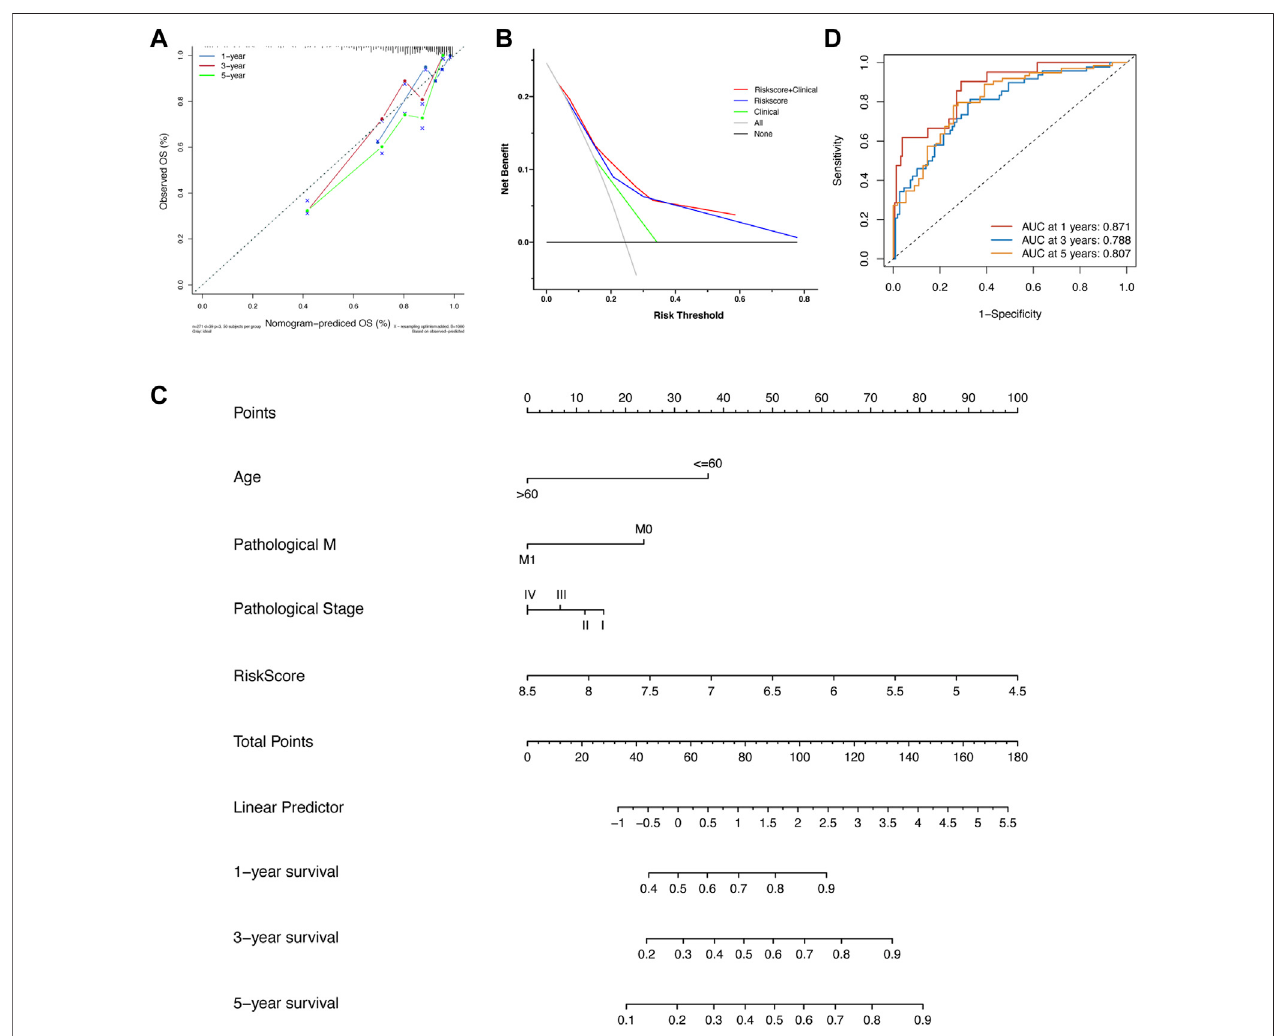
FIGURE 5 | (A) The calibration analysis suggested that the prognostic performance of the risk score model was stable. (B) The DCA analysis showed that the prognostic ability of the risk score model plus clinical factors was best, followed by the risk score model alone and clinical factors alone. (C) The nomogram was built based on the risk score model and several clinical variates. (D) The ROC analysis of nomogram in the training set.